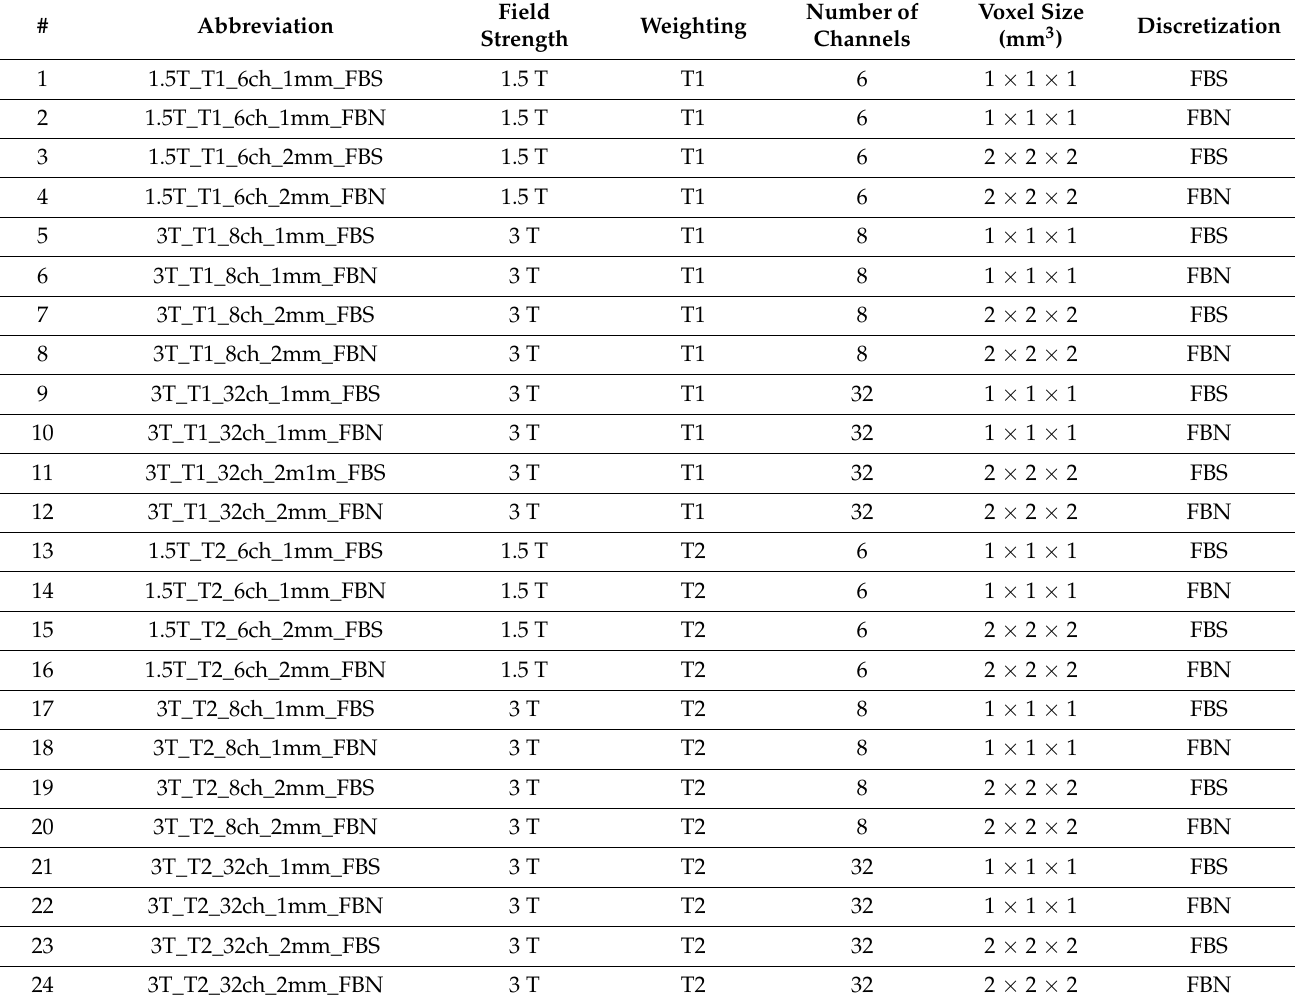
Table 2. Abbreviations for the different imaging setups. The second column shows the setup parameters, listing the filed strength, the weighting (T1 or T2), the applied coil type, the acquisition voxel size, and the discretization method. A total of 24 settings were considered for each RI